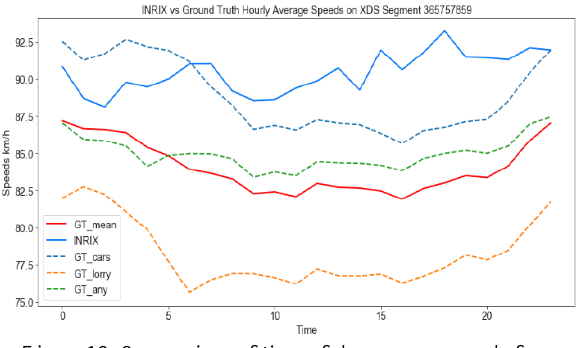
Figure 12: Comparison of time-of-day average speeds from INRIX FCD stationary detectors on INRIX segment XDS 365757859 (775m). The individual vehicle category speeds from the detectors are shown in dashed